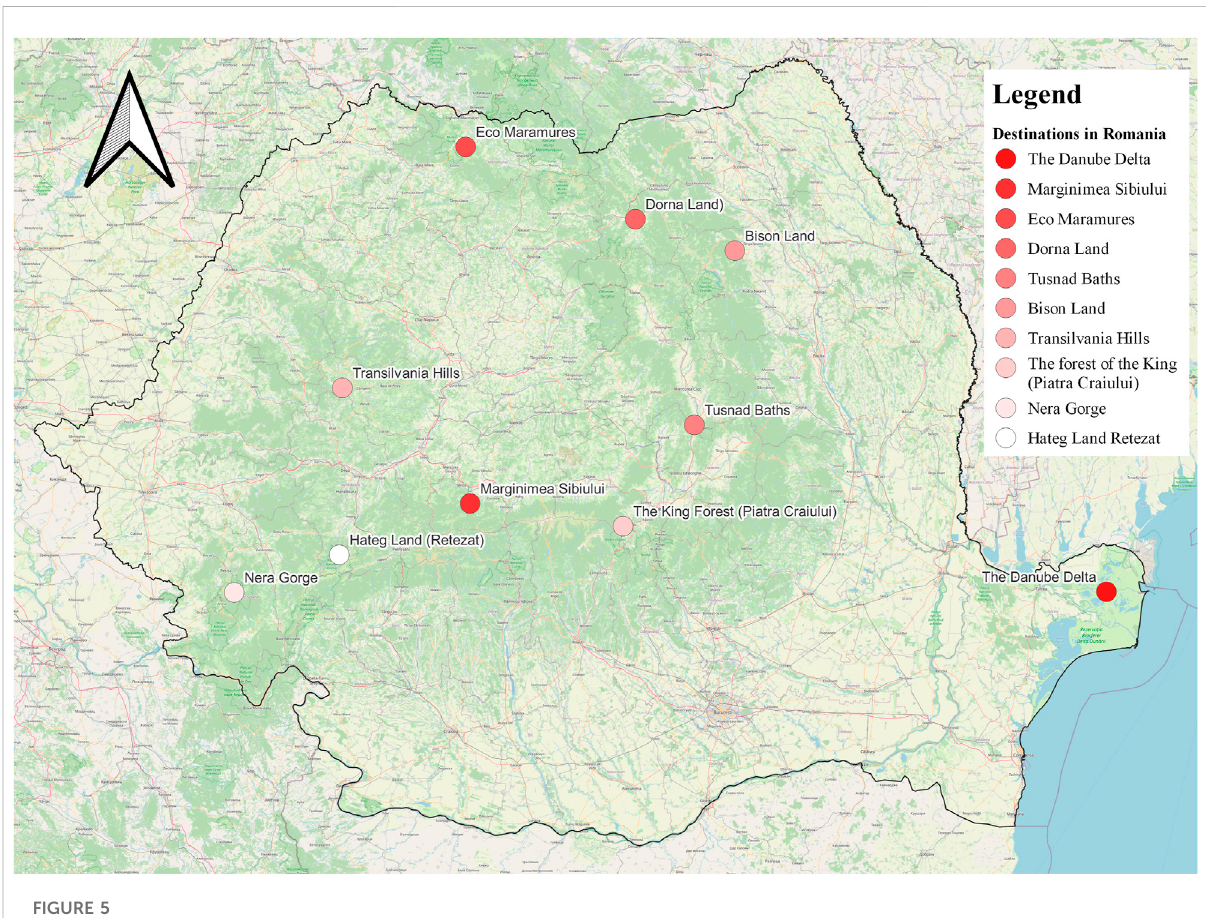
FIGURE 5 Most famous ecotourism destinations in Romania.